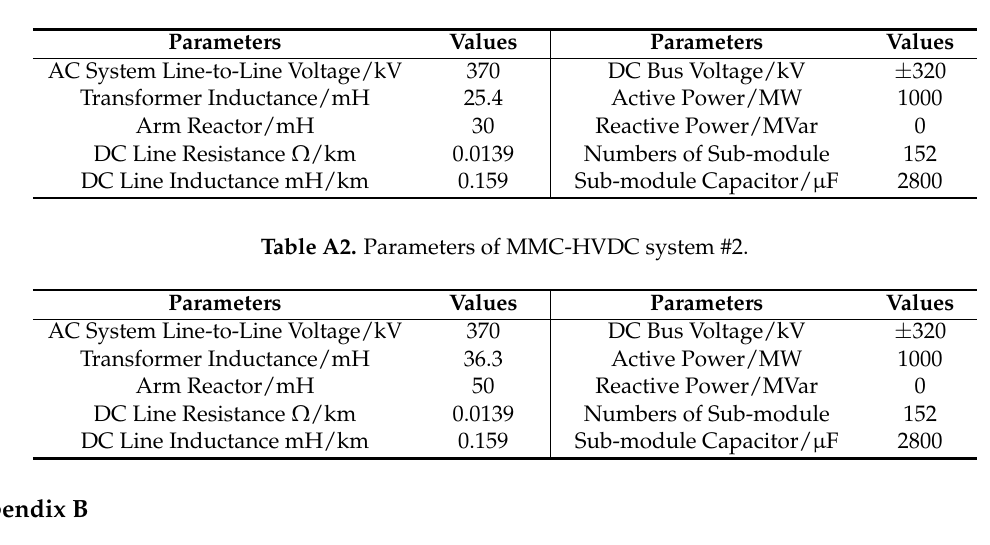
Table A1. Parameters of MMC-HVDC system #1.